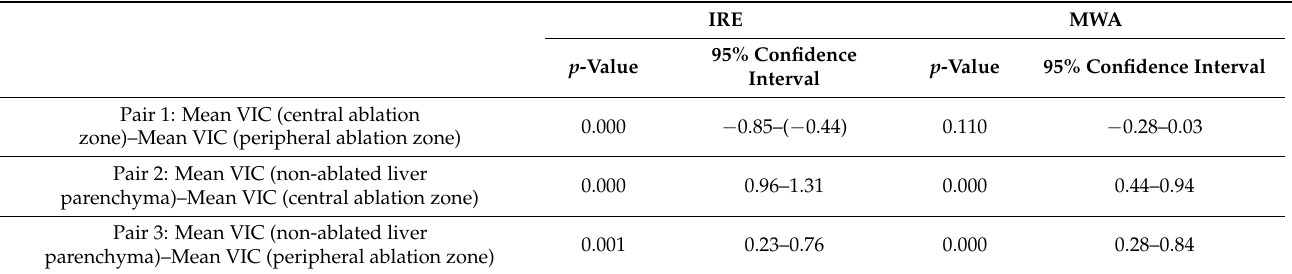
Table 2. T-test for paired samples of the VIC after IRE and MWA in each patient group. IRE MWA 95% Confidence p -Value 95% Confidence Interval p -Value Interval